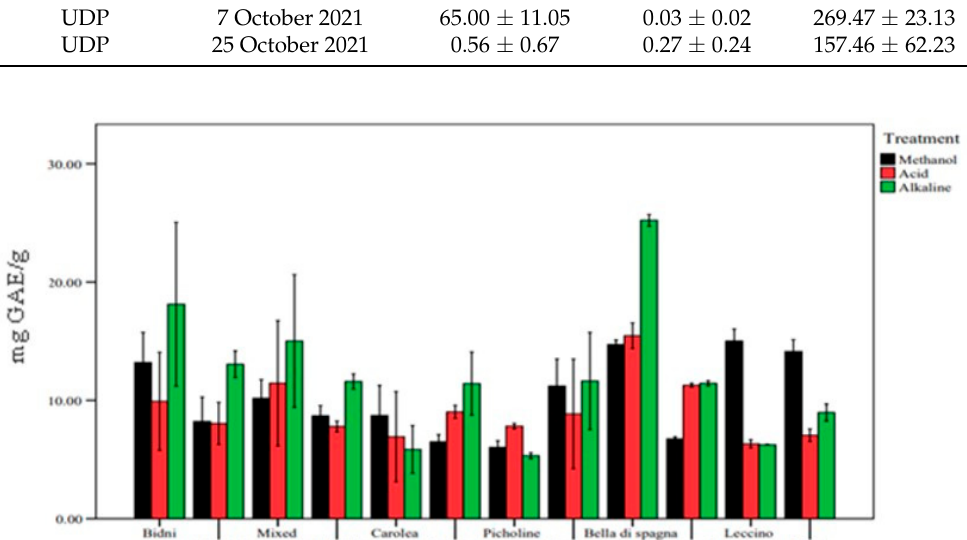
Figure 6. Mean of cupric reducing antioxidant activity of olive mill waste extracts using three different solvent extraction methods—methanol, acid and alkaline (black, red and green bars, respectively) with error bars showing ± 1SD for three independent trails.